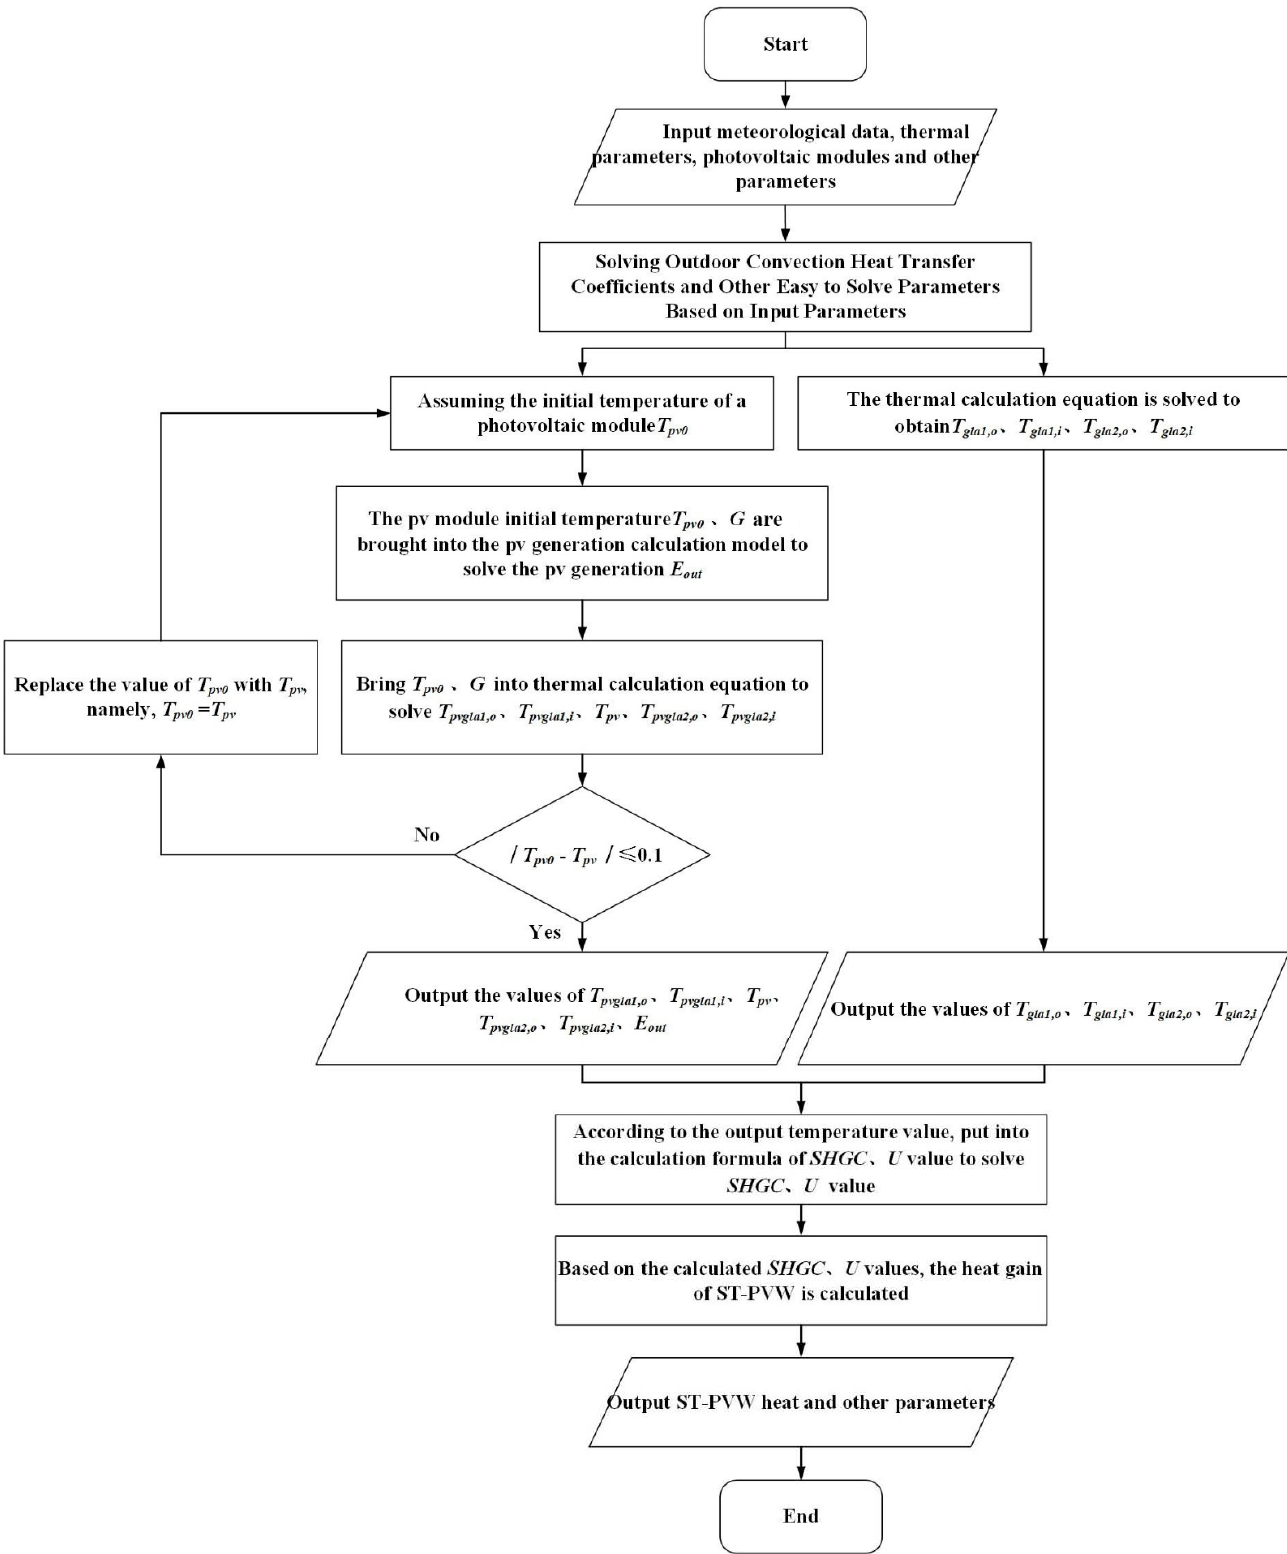
Figure 2. Thermal-electric coupling calculation flowchart for ST-PVW.